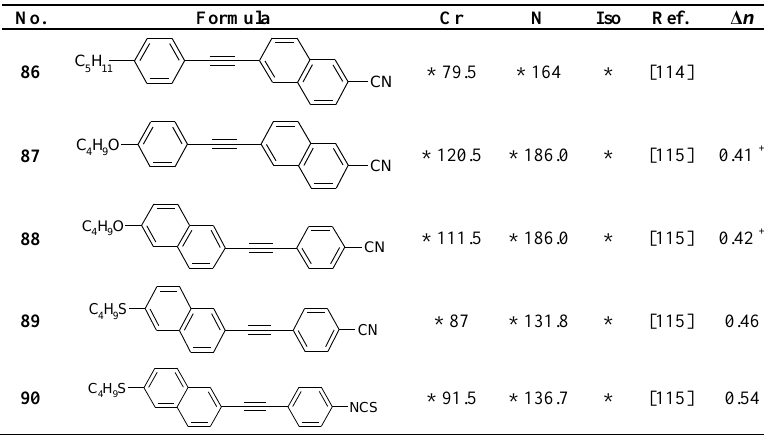
Table 12. Phase transition temperatures [°C] and birefringence of three-ring acetylenes with naphthalene moiety.